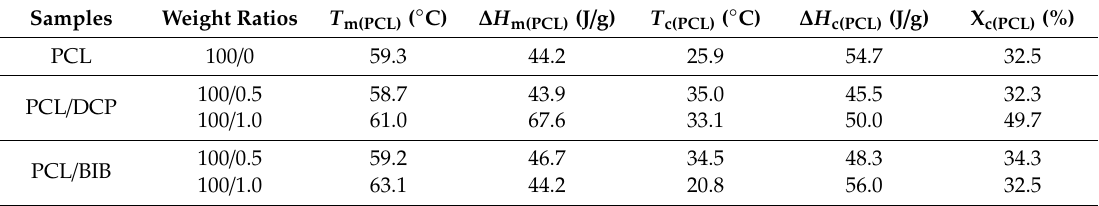
Table 2. DSC parameters (second heating) of PCL modified by DCP and